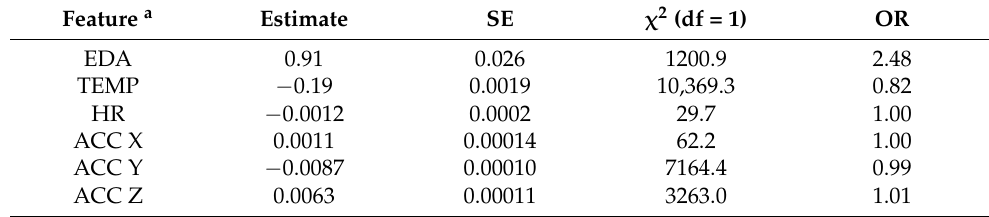
Table 2. Parameter estimates from the ordinal logistic regression model (threshold values omitted).